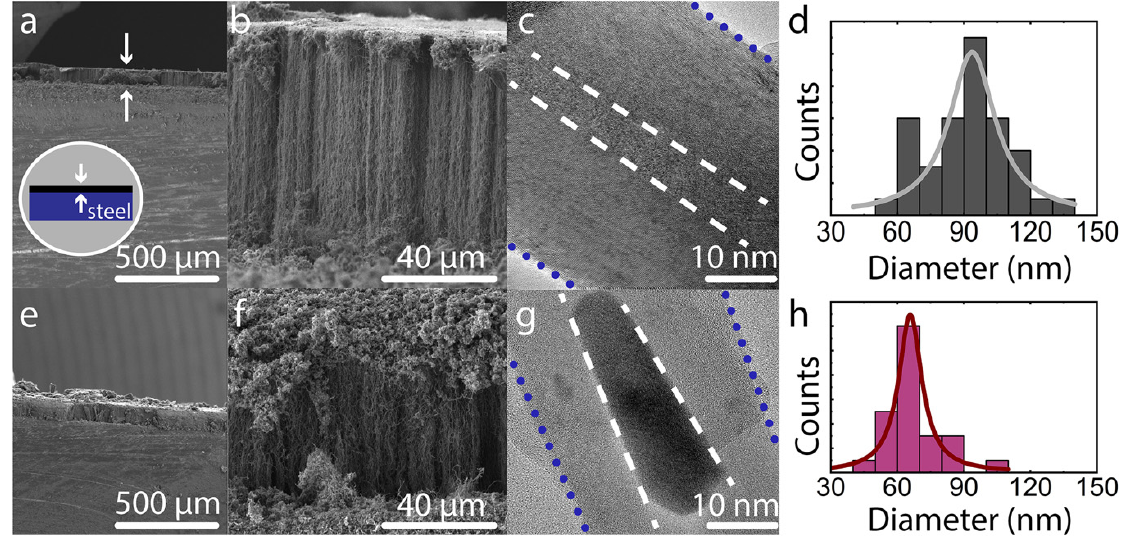
Figure 2. ( a , b ) Representative SEM images of sample S1; ( c ) HRTEM image of individual CNT from sample S1; dash lines mark the inner tube wall and dotted lines mark the outer CNT wall; ( d ) outer diameter size distribution for sample S1; ( e , f ) SEM images of sample S4; ( g ) HRTEM image of individual CNT from sample S4; ( h ) measured outer diameter size distribution for sample S4.